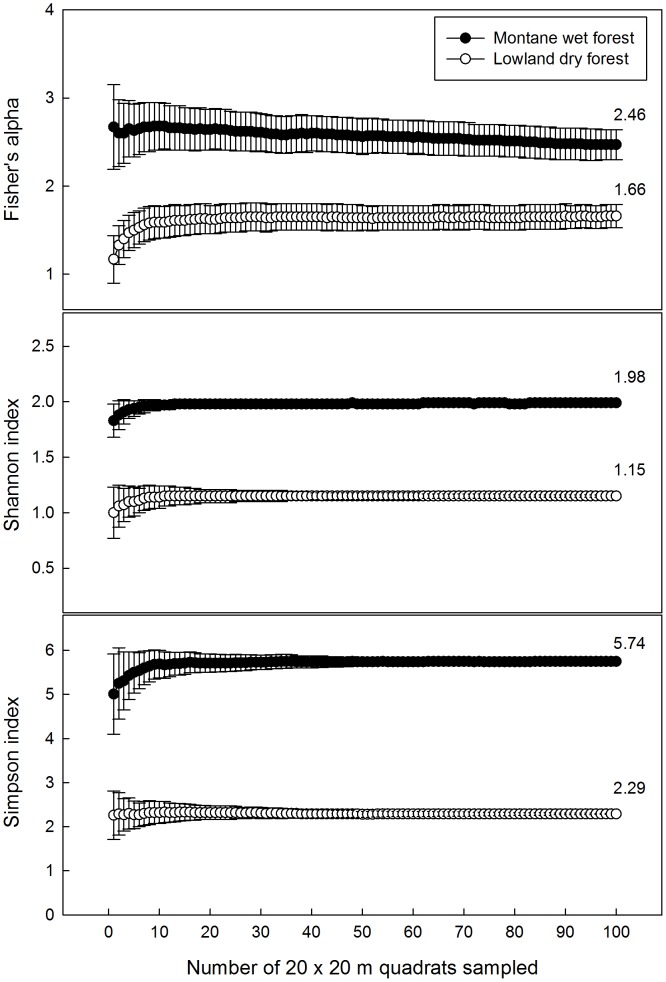
Species diversity indices.Fisher's alpha, Shannon index, and Simpson index for the Hawaiian montane wet forest (MWF) and lowland dry forest (LDF). Each 20×20 m subplot is shown, with the values being cumulative and number above each line representing the entire plot area (4-ha). Values are the diversity index and standard deviation, as estimated by the program EstimateS.